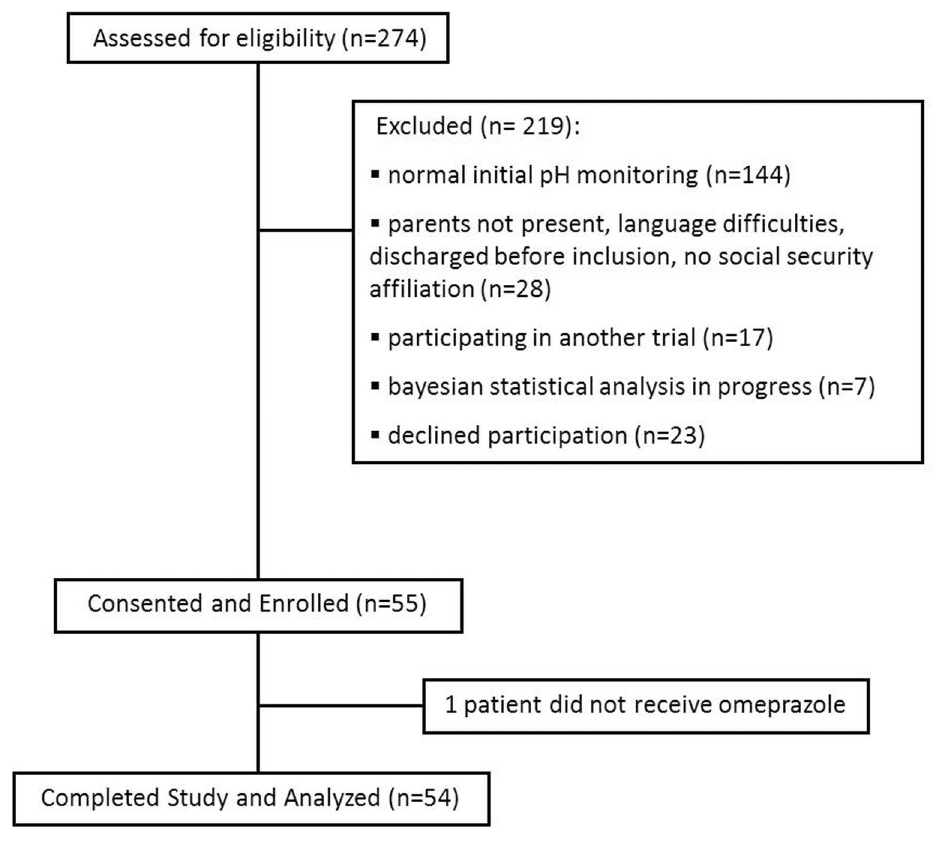
Fig 1. Flow chart of patients.